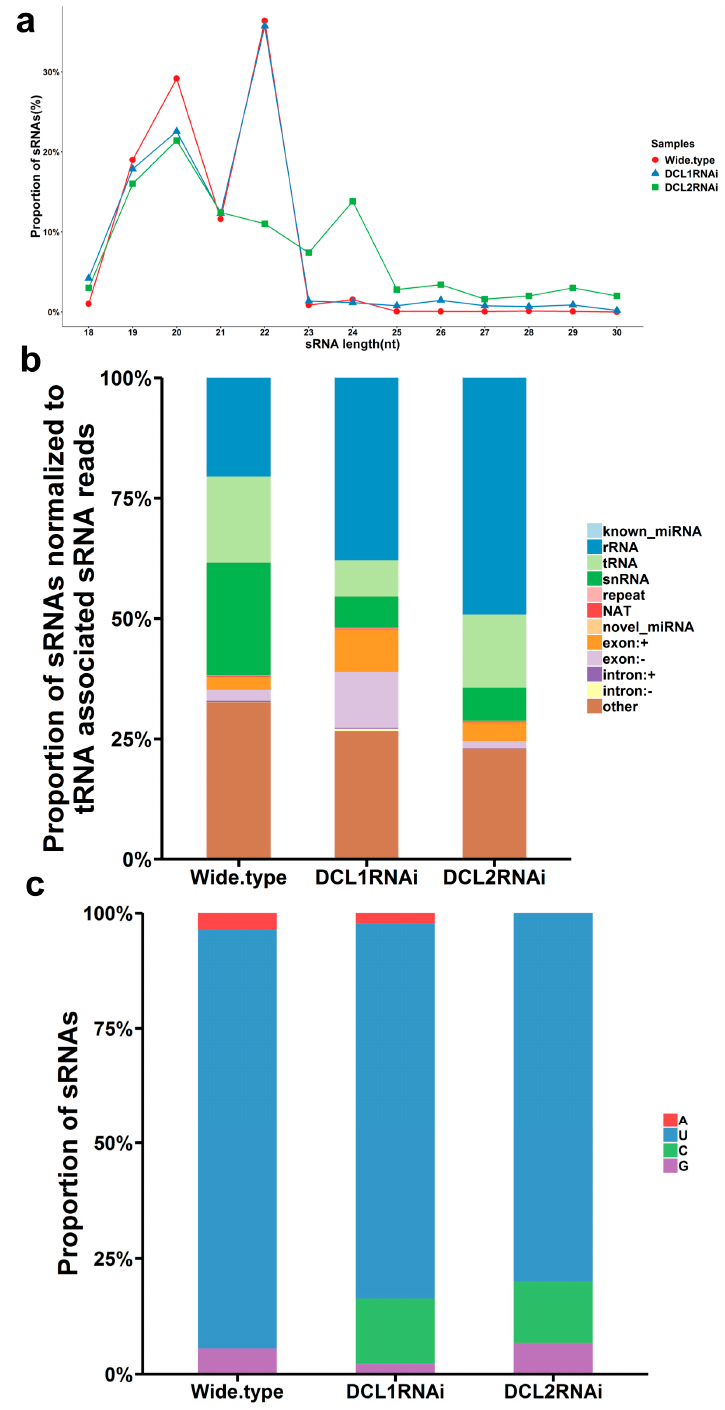
Figure 5. Characteristics of the small RNAs (sRNAs) in different samples. ( a ) Size distribution of sRNA from wild-type P. italicum and the RNAi transformants. ( b ) Proportion of total genome-matched sRNA from wild-type P. italicum and the RNAi transformants. ( c ) 5 ′ Nucleotide preference for sRNAs in wild-type P. italicum and the RNAi transformants.